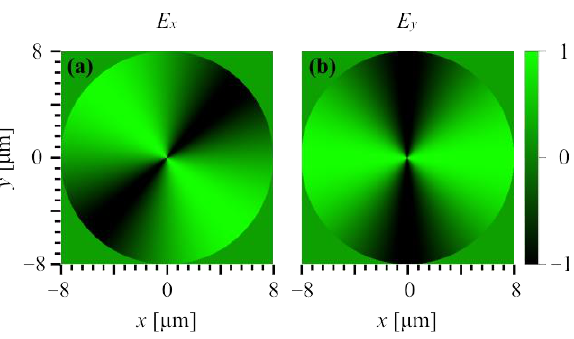
Figure 4. The electric field components E x ( a ) and E y ( b ) of the incident CVB.